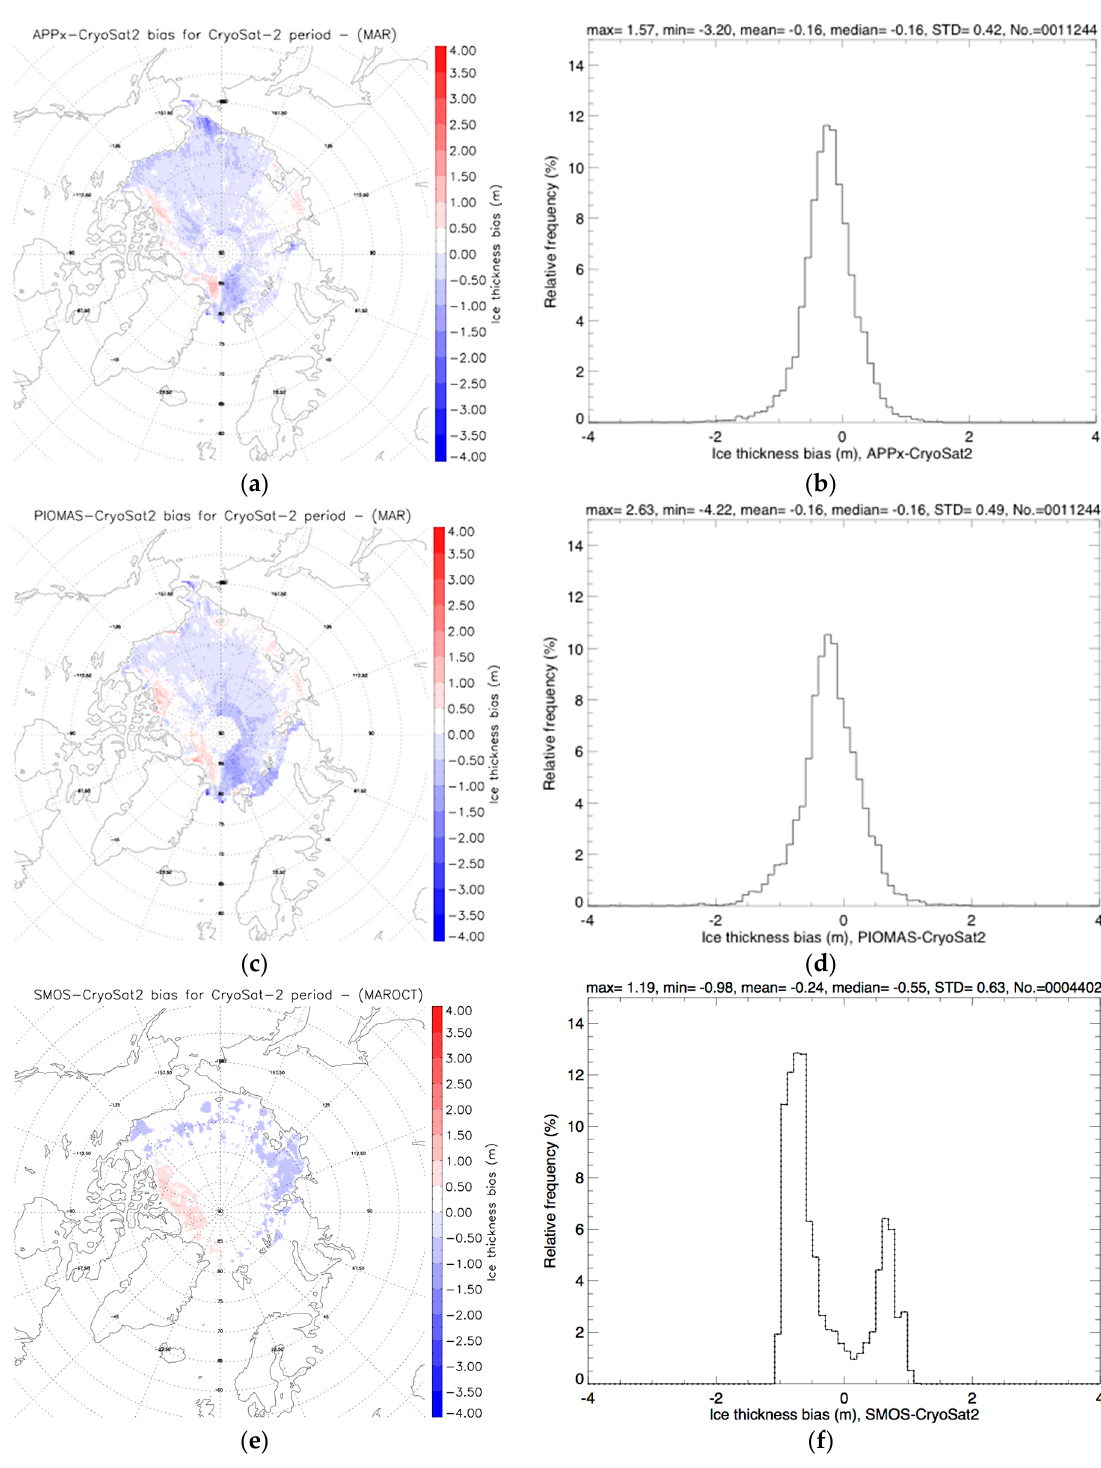
Figure 5. ( a – f ) Comparisons in sea ice thickness from APP-x, PIOMAS, and SMOS in terms of CryoSat-2 sea ice thickness for the Winter period (MAR), 2011–2013. The bias images for APP-x in ( a ); PIOMAS in ( c ); and SMOS in ( e ) are shown on the left, and the bias histograms for APP-x in ( b ); PIOMAS in ( d ); and SMOS in ( f ) are shown on the right. The SMOS results are only for CryoSat-2 thicknesses of 1 m and less.